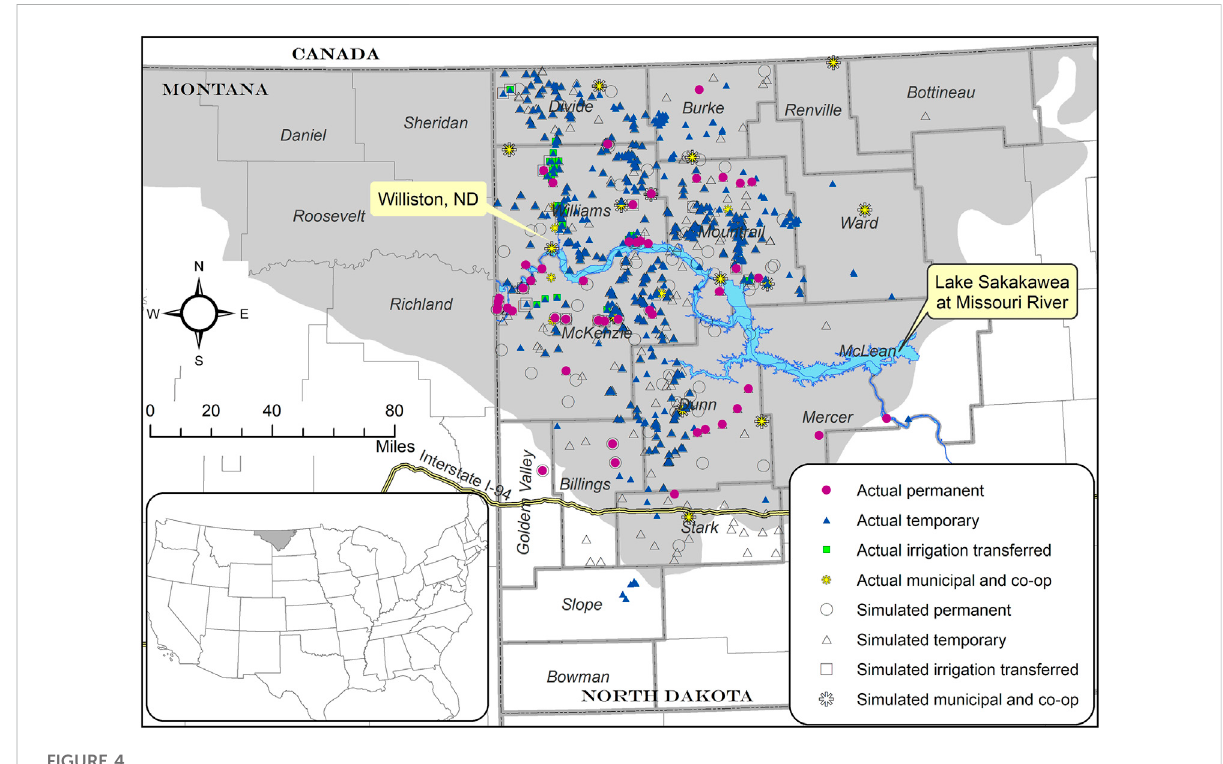
FIGURE 4 Comparison of the actual and the model-simulated locations of all water depots.